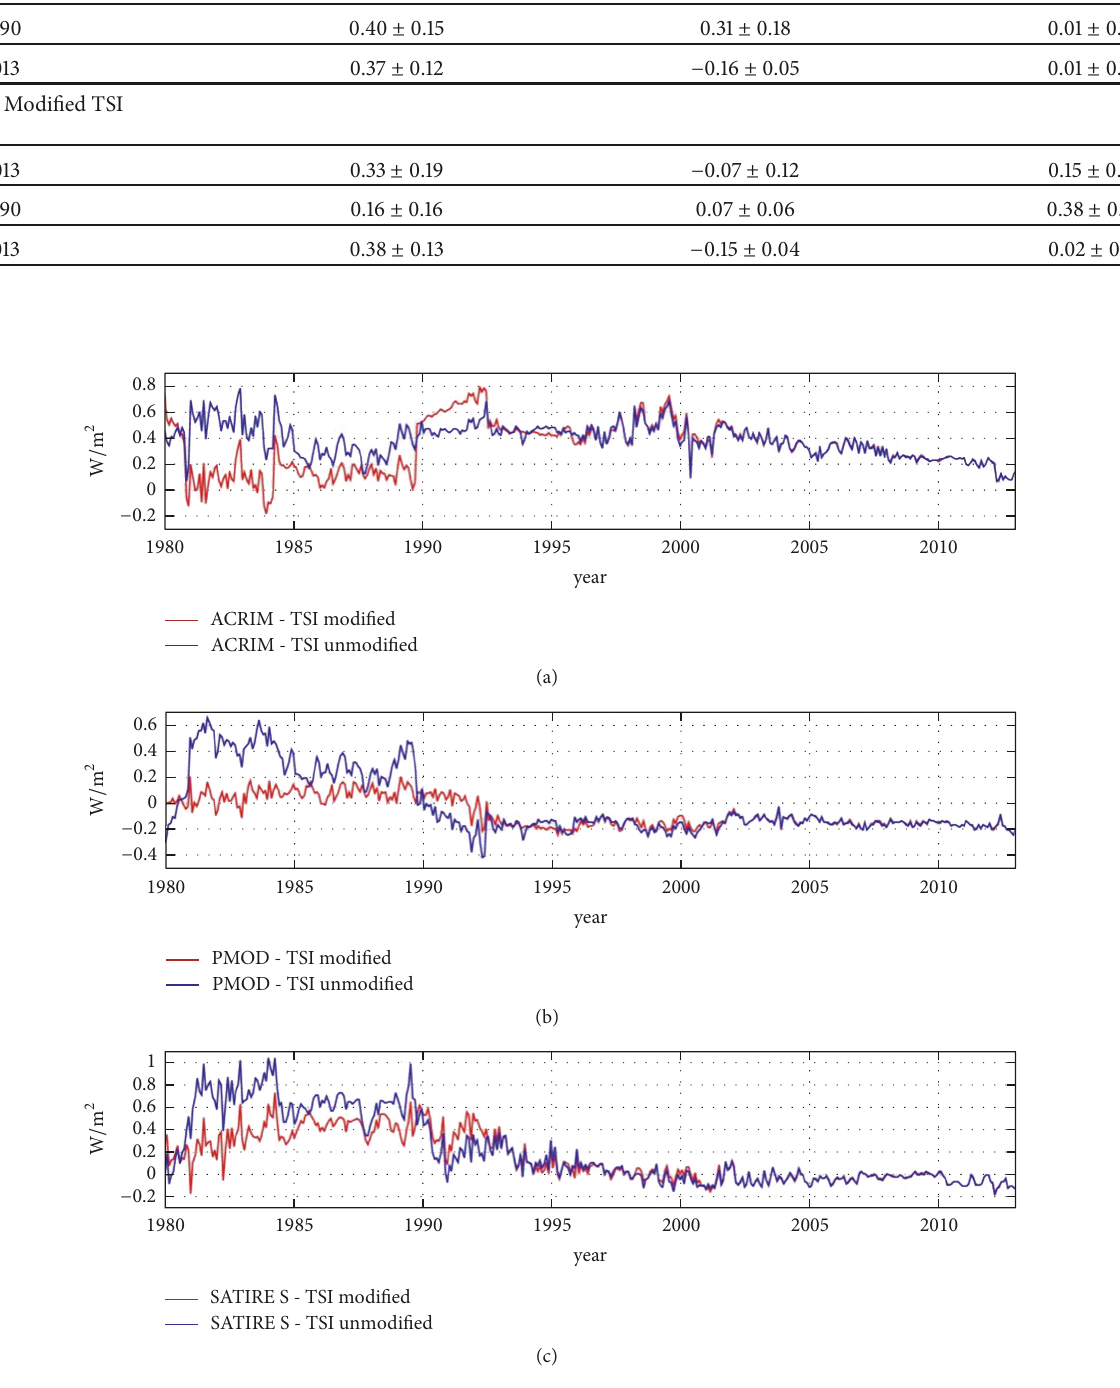
Figure 6: (a) Variation between the ACRIM TSI composite and the unmodified and modified TSI by Dudok de Wit et al. [9] from 1980 to 2013. (b) and (c) The same using the PMOD TSI composite and the SATIRE TSI proxy model. Plots are based on monthly